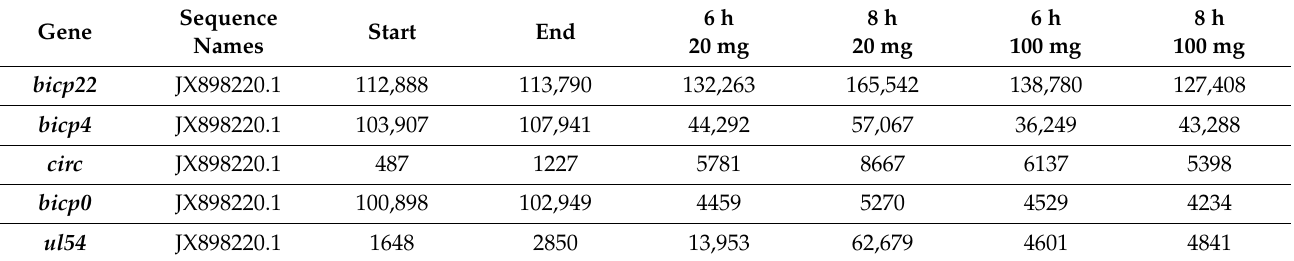
Table 2. Genes expressed in CHX-treated